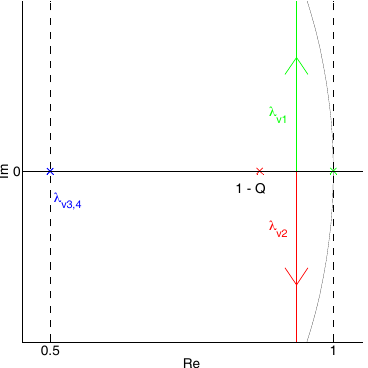
Figure 5. Root-locus chart for voltage control poles 𝜆 (cid:3049)(cid:2869),(cid:2870) and disturbance observer poles 𝜆 (cid:3049)(cid:2871),(cid:2872) . The natural frequency ω (cid:3049)(cid:2870) of pole 𝜆 (cid:3049)(cid:2870) should be more than five times the natural frequency ω 𝜆 (cid:3049)(cid:2869) of pole (cid:3049)(cid:2869) . This is possible only if both poles are placed on the real axis, and the condition is (50) (similar as for the current part (25)).